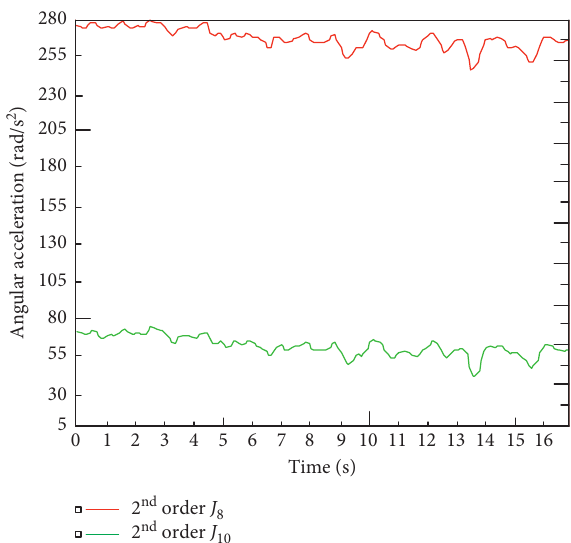
Figure 31: The 2 nd order angular acceleration curves of the primary flywheel and the input shaft of the gearbox matching the DMF with the bifilar CPVA under the idling condition.